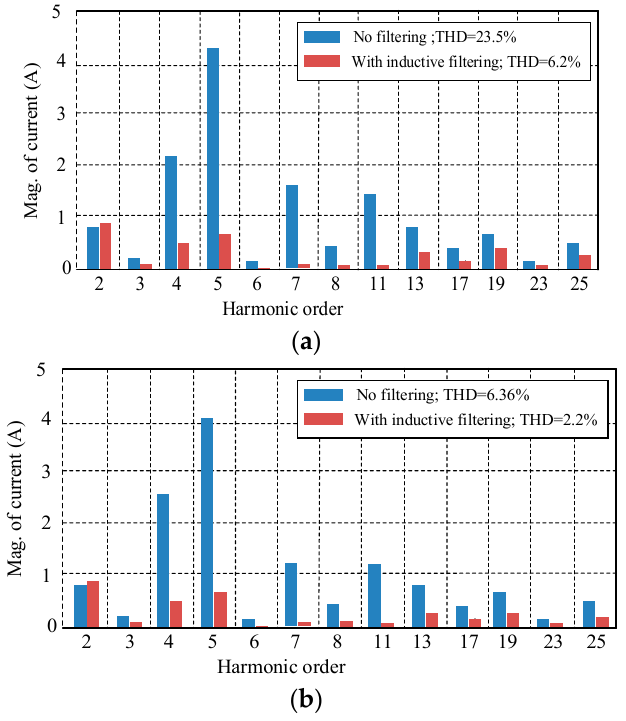
Figure 15. FFT results on the current waveform in the grid winding. ( a ) Output power of wind farm is 4.5 MW; ( b ) Output power of wind farm is 15